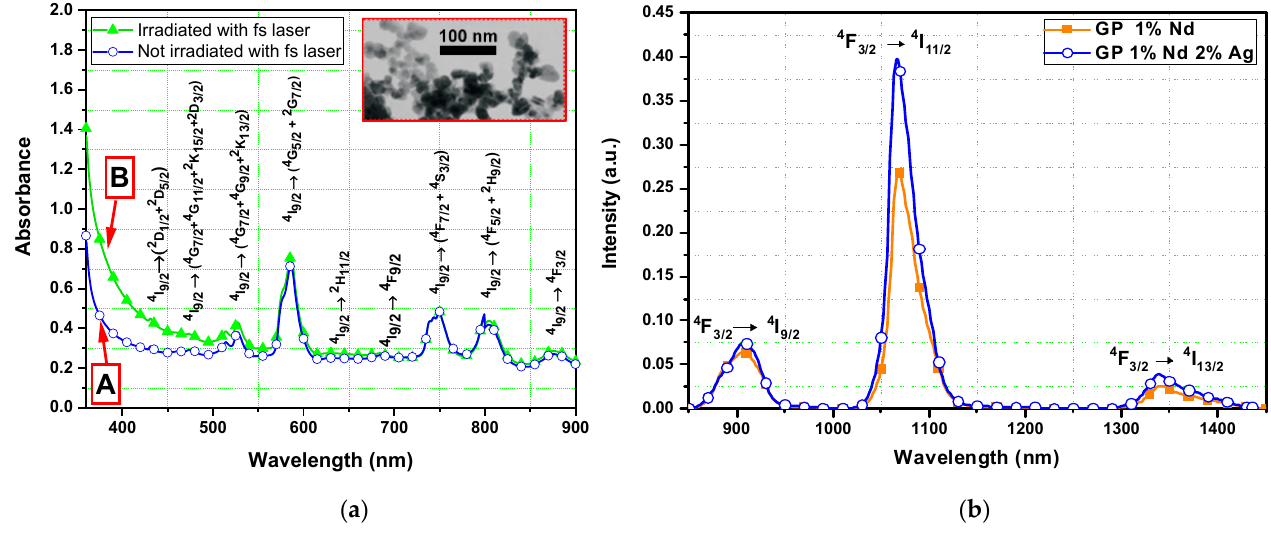
Figure 3. ( a ) Absorbance results of GeO 2 -PbO glass doped with Nd 3+ and Ag NPs in two different regions of the sample (in laser focal region); the inset shows the TEM image of Ag NPs [11]; ( b ) photoluminescence spectra for Nd 3+ -doped Ge 2 O-PbO glass without (square) and with (open circles) Ag NPs.